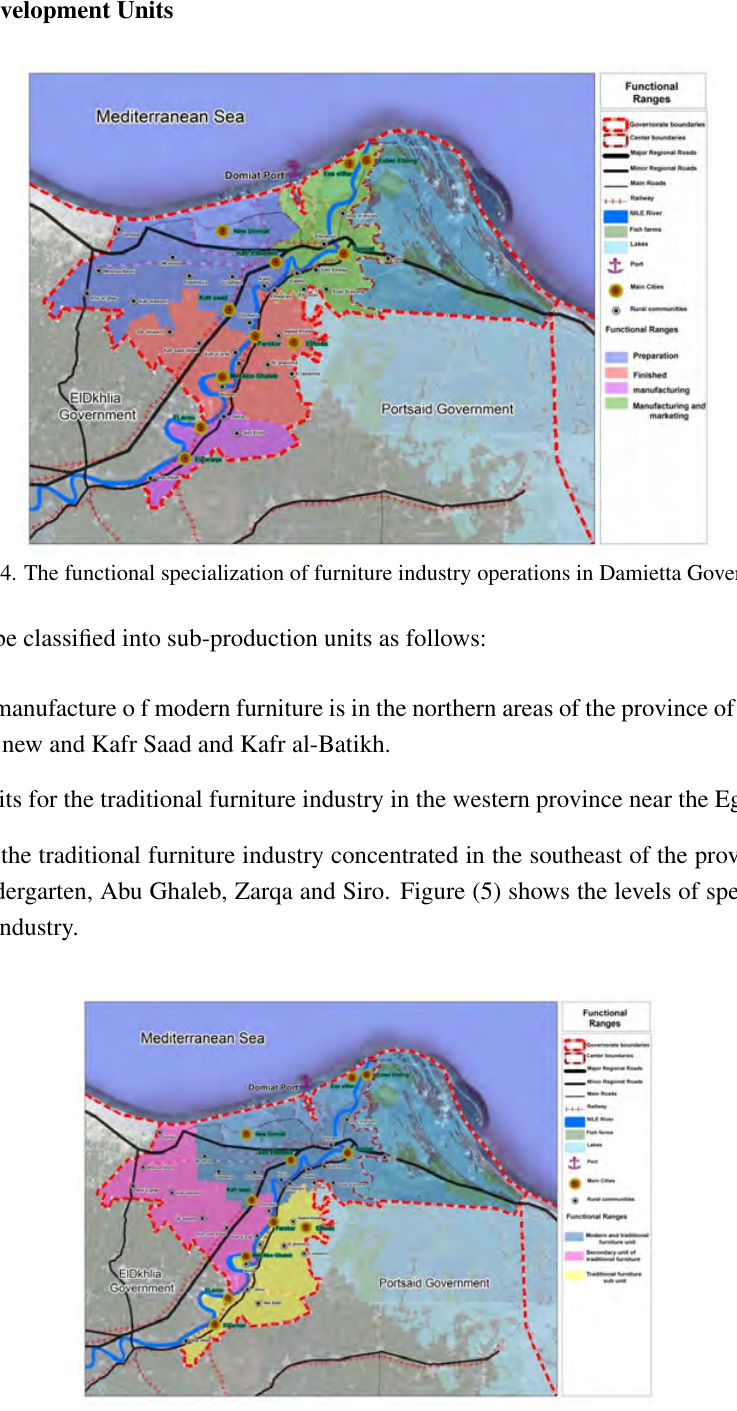
Figure 5. levels of specialization units for thefurniture industry